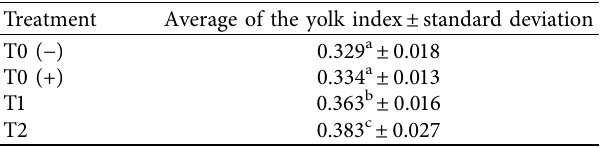
Table 4: Average of the yolk index in quails ( Coturnix coturnix japonica ).